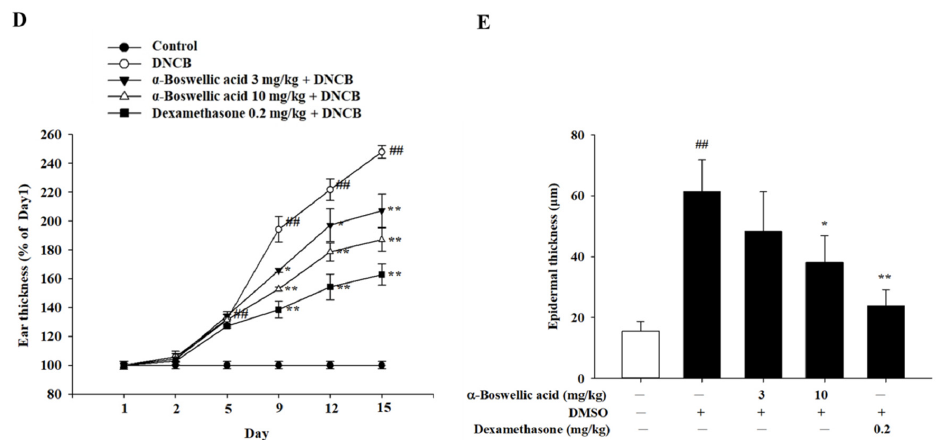
Figure 1. Effects of α -boswellic acid on the histological characteristics of mice with DNCB-induced AD. ( A ) Effect of α -boswellic acid on DNCB-induced atopic dermatitis in dorsal skin. ( B ) Effect of α -boswellic acid on DNCB-induced atopic dermatitis in ears. H&E staining of ear tissue sections. Red arrows point to the epidermis. ( C ) Toluidine blue staining of the dorsal skin; scale bar: 50 μ m (upper panel) and statistical analysis of the mast cells (lower panel). The red arrow points to the mast cells. ( D ) Statistical analysis of the ear thickness. ( E ) Histogram of the epidermal thickness. Values represent the mean ± SEM from three independent experiments. * p < 0.05 and ** p < 0.01 vs. the DNCB-only-treated group; ## p < 0.01 vs. the untreated group. zene Induced Atopic-like Dermatitis in BALB/c Mice To determine the effect of α -boswellic acid on DNCB-induced skin TEWL in the epi- dermal layer of mice, TEWL was assessed five times between Days 1 and 15. On the last day of the experiment, increased TEWL was observed in DNCB-induced mice compared